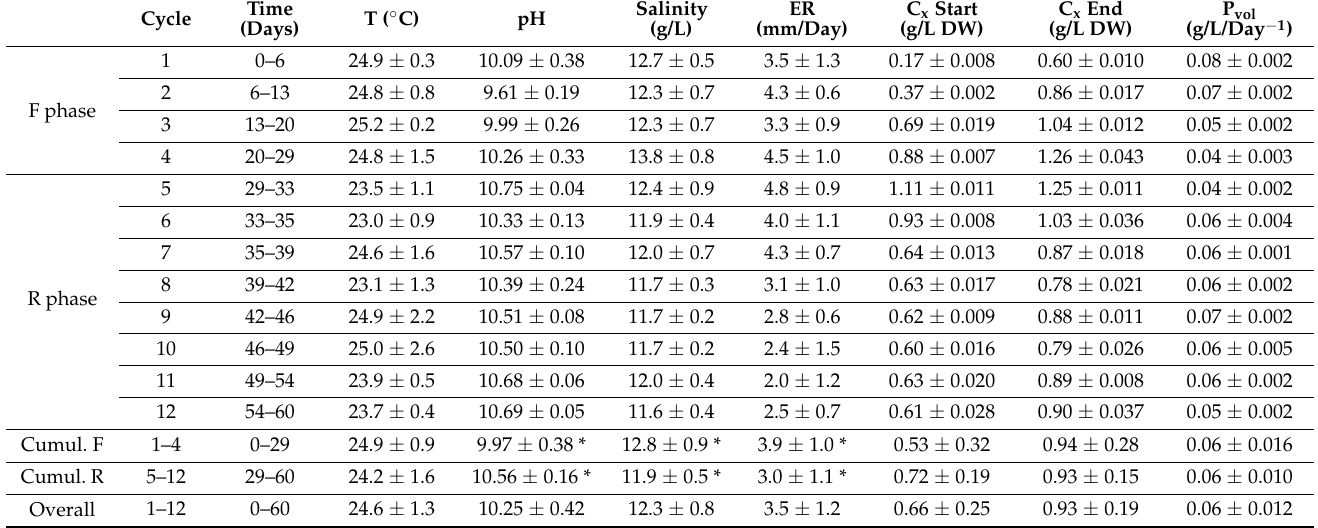
* For each parameter, asterisk indicates differences at the significant level p < 0.05 (Student’s t -test) with respect to the other experimental phase. Abbreviation: